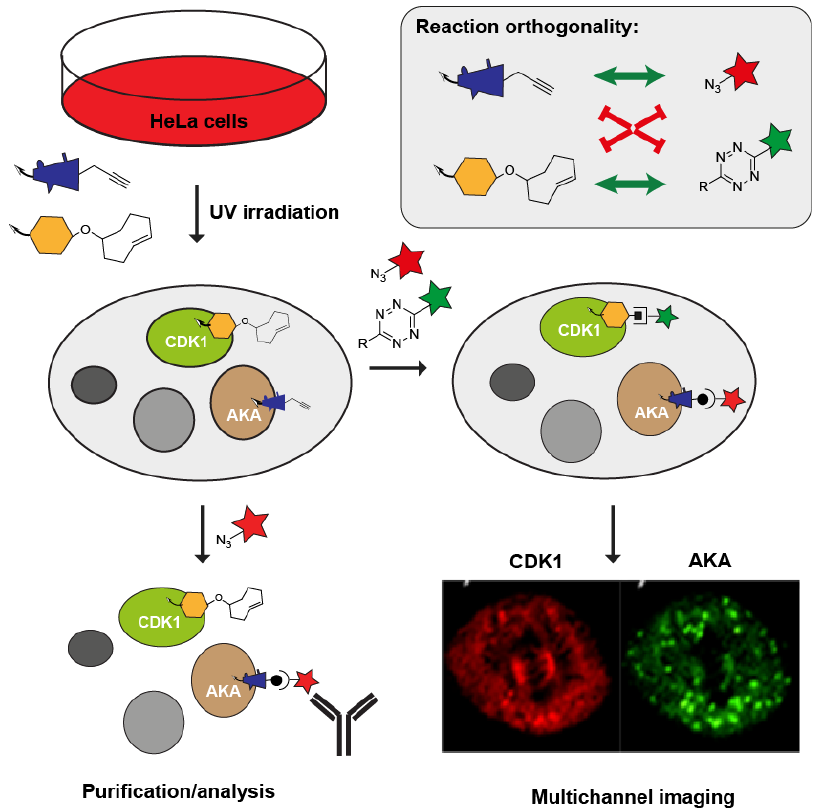
Figure 5. Orthogonality between bioorthogonal ligation reactions enables the simultaneous profiling of multiple enzyme targets. Figure exemplifies the experiment performed by Su et al. demonstrating subcellular localization of two cell cycle regulating kinases, cyclin-dependent kinase 1 (CDK1), and Aurora Kinase A (AKA). By using a two-step labeling approach, the same experimental samples could be used for enrichment as well as for imaging of the proteins. Fluorescent image taken from [82].